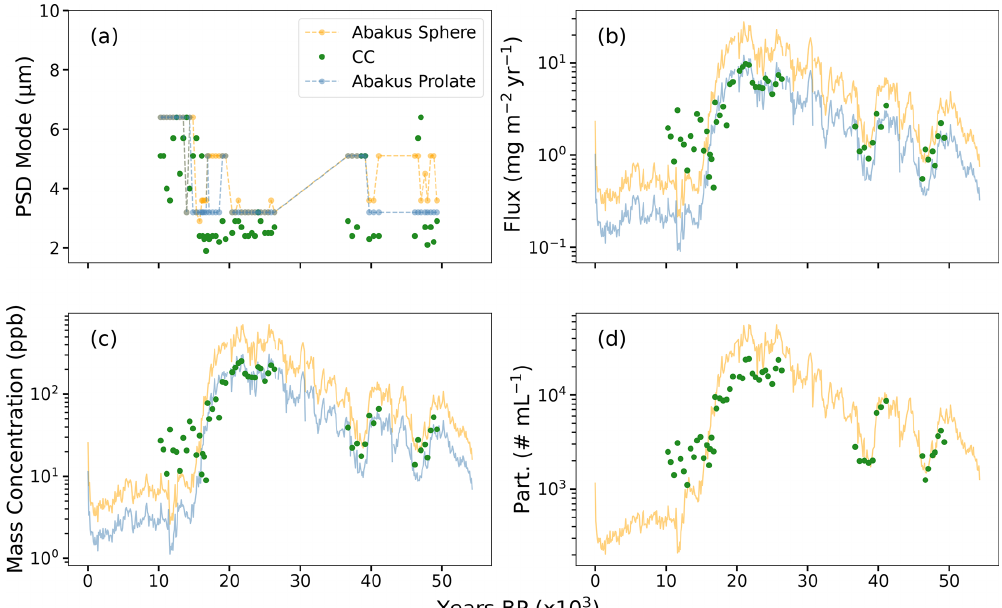
Figure 5. Comparison of CC and Abakus spherical and ellipsoidal (prolate, Eq. 1b) particle data including (a) volume mode, (b) flux, (c) mass concentration, and (d) number concentration. The Abakus-calculated prolate data are a better fit to the CC data for all volume-related metrics (flux, mass concentration, ppb, and PSD). Number concentrations (d) are unaffected by particle shape.